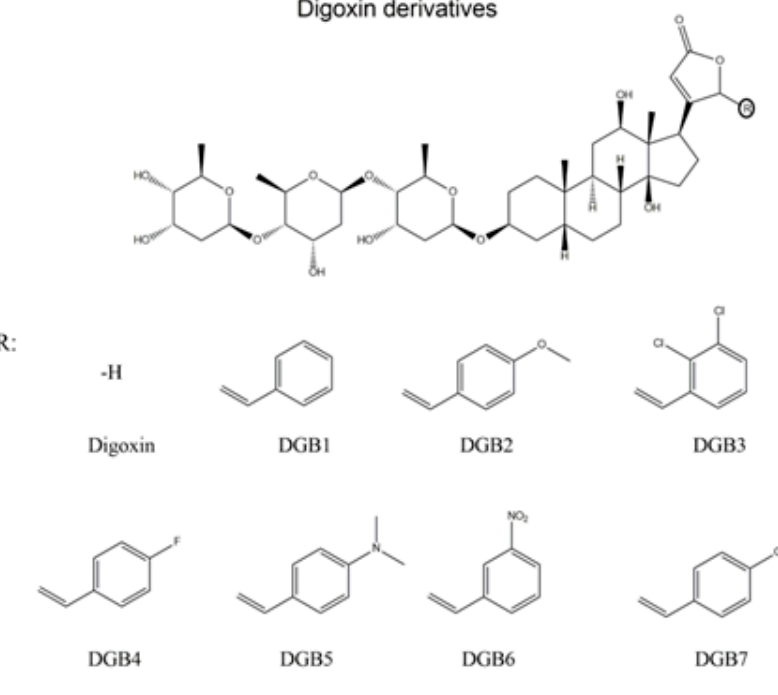
Figure 1. Structure of digoxin and its